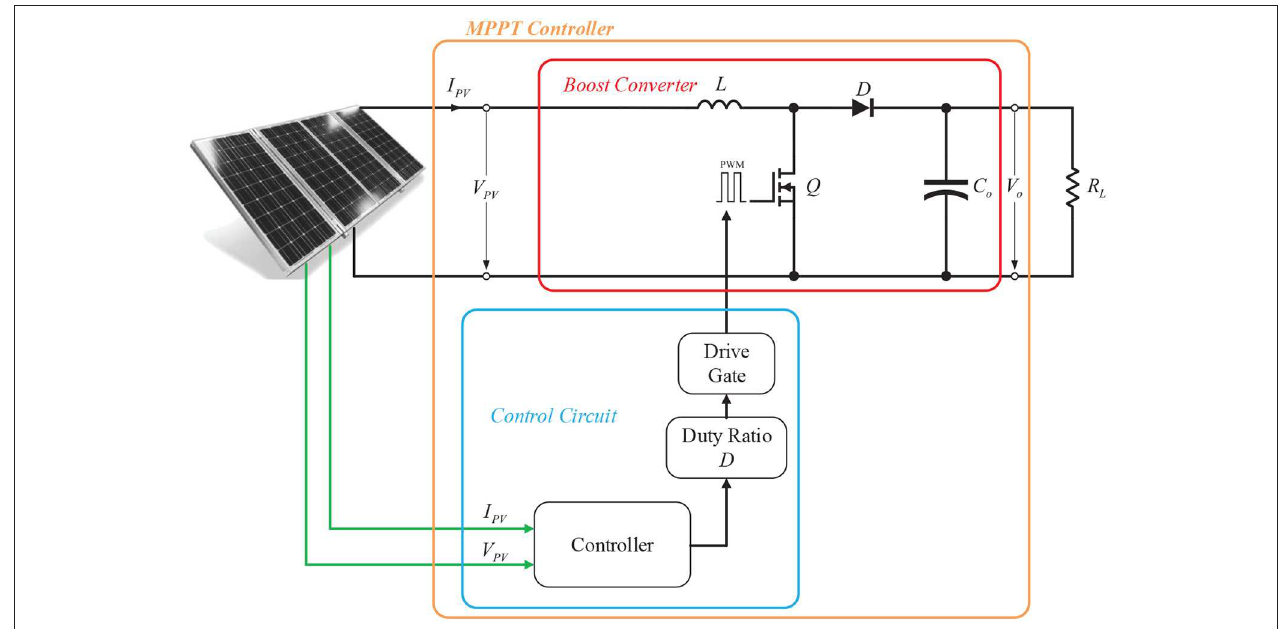
FIGURE 3 | PV maximum power point tracking